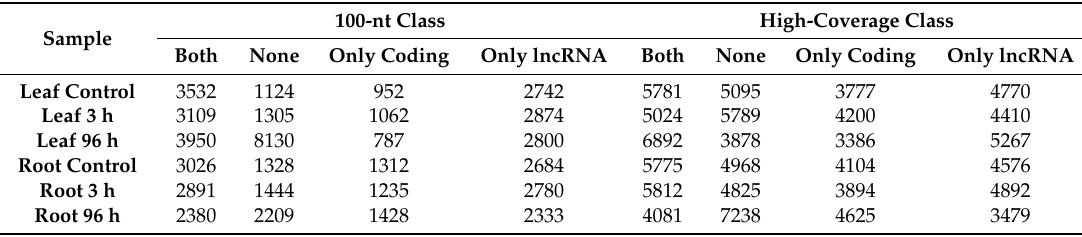
Table 1. Trans natural transcript (trans -NAT) pairs classification and expression distribution in all